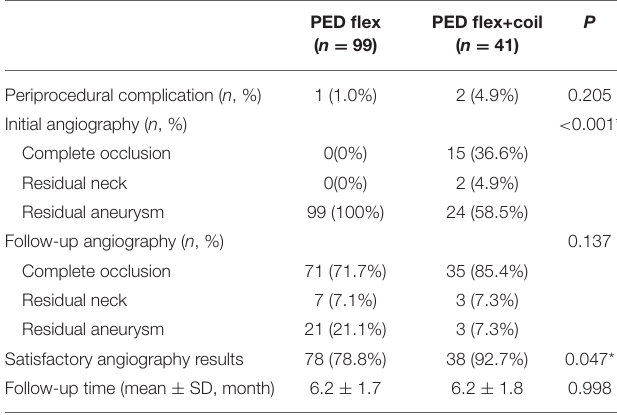
TABLE 3 | Treatment-related